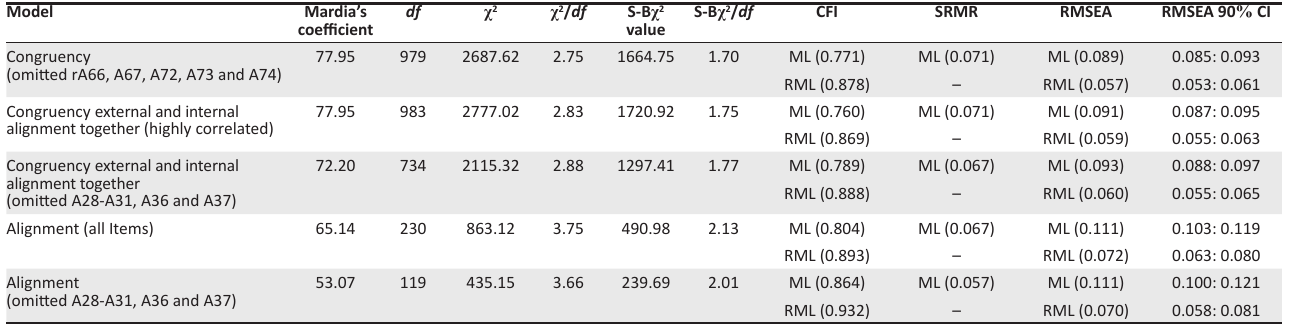
TABLE 2 (Continues...): Structure equation modelling results. Model Mardia’s